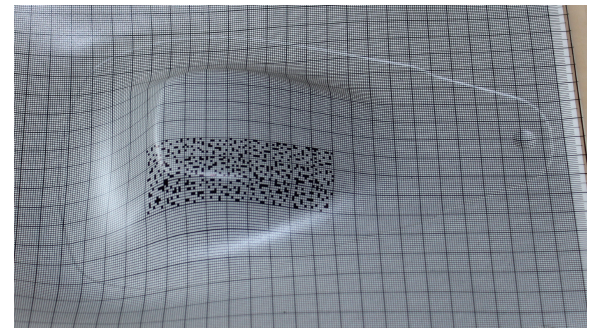
Figure 1. Coated laminate film.